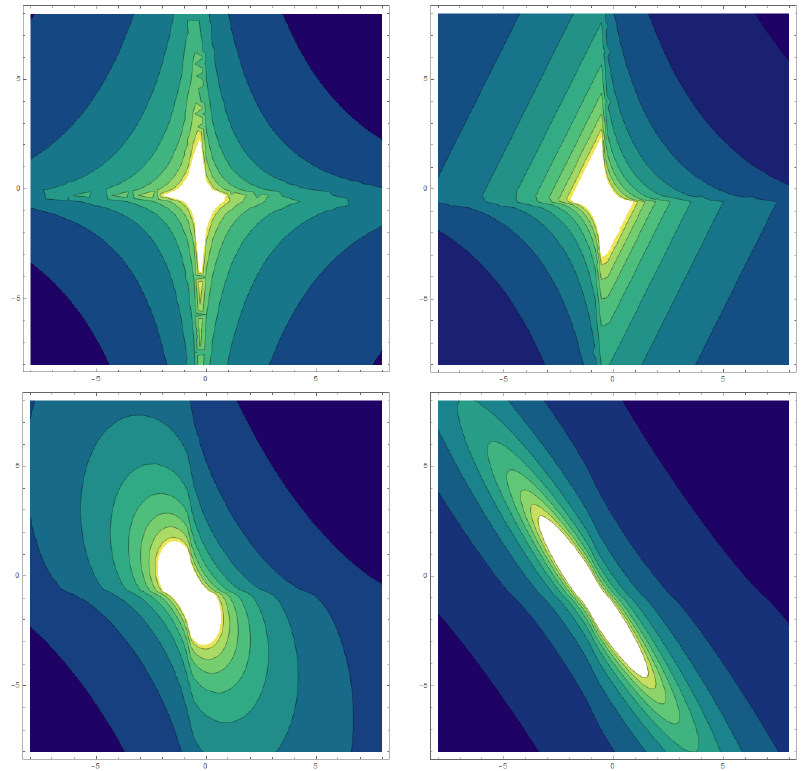
Figure 12. The 2D contour graphs of | L 31 | across different values of β